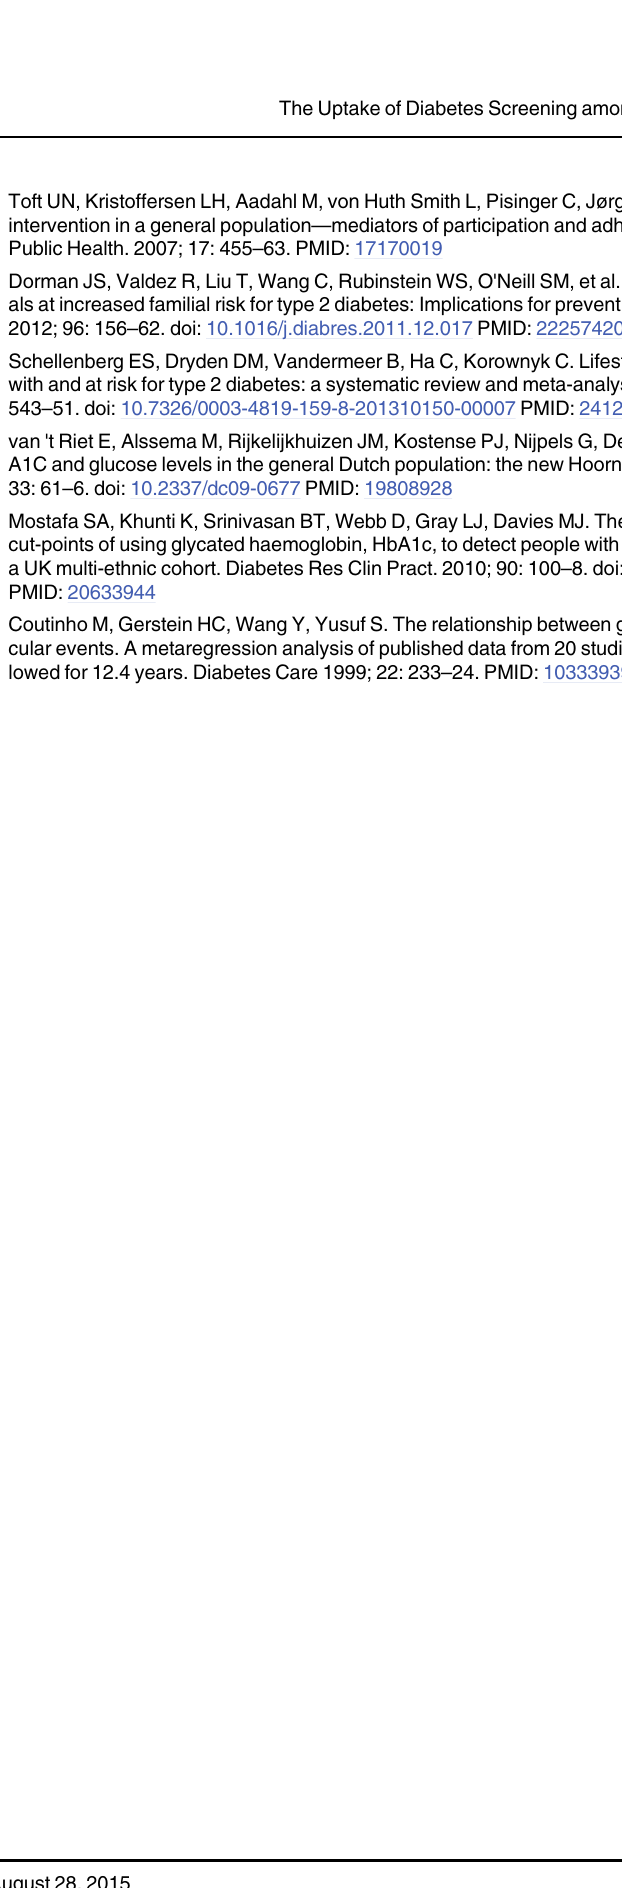
PLOS ONE | DOI:10.1371/journal.pone.0136734 August 28,